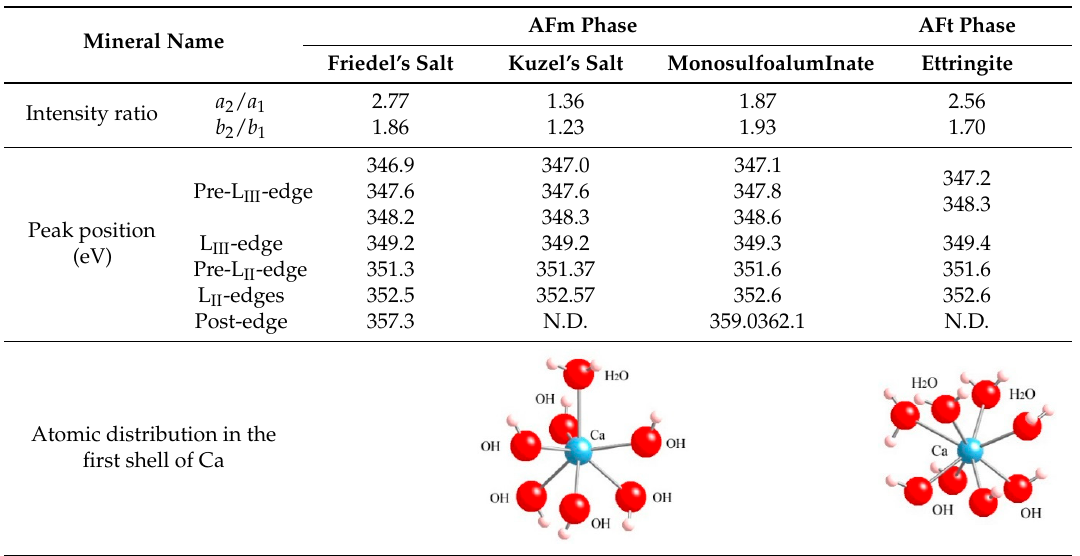
Figure 1. XANES (X-ray Absorption Near Edge Structure) reference spectra of Ca L III,II -edge of synthesized Kuzel’s salt, Friedel’s salt, monosulfoaluminate, and ettringite. The broken lines indicate spectral features. Table 1. Ca L III , II -edge XANES intensity ratios and peak positions of Friedel’s salt, Kuzel’s salt, monosulfoaluminate, and ettringite, and coordination within the first shell of calcium (N.D.: Not Detected).